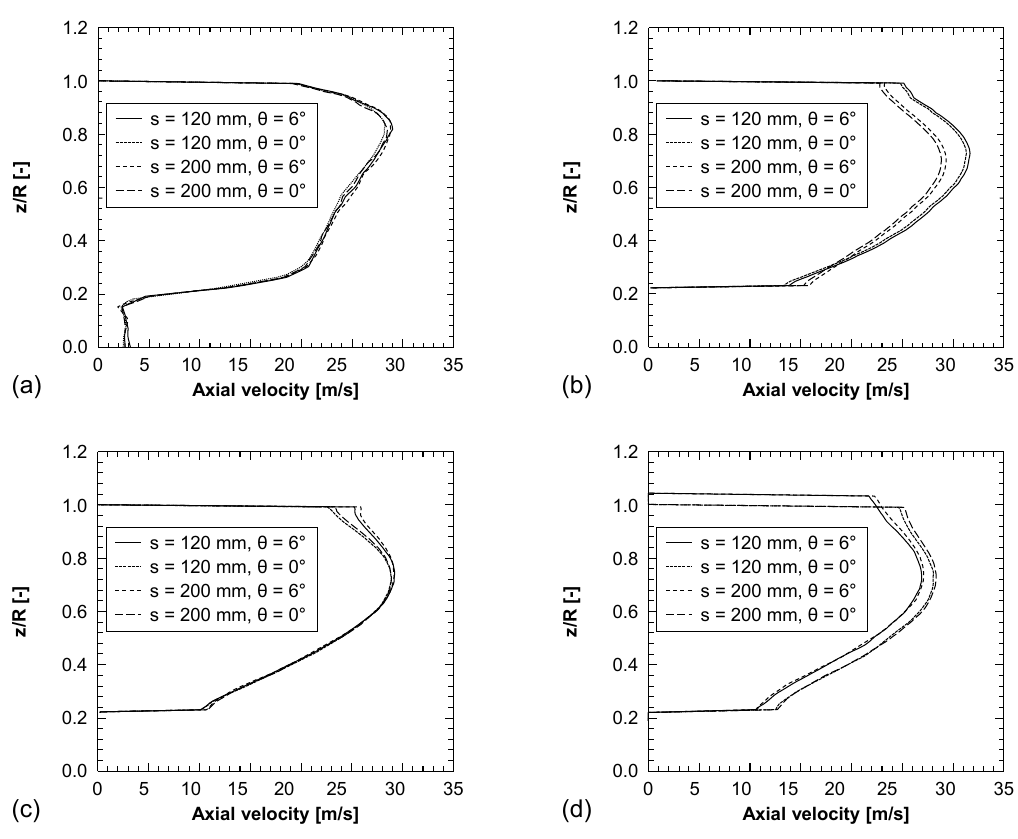
Figure 11. Axial velocity profile along the radial direction at 2700 rpm in ( a ) Plane 1; ( b ) Plane 2; ( c ) Plane 3; and ( d ) Plane 5. See Figure 6 for the location of the planes.